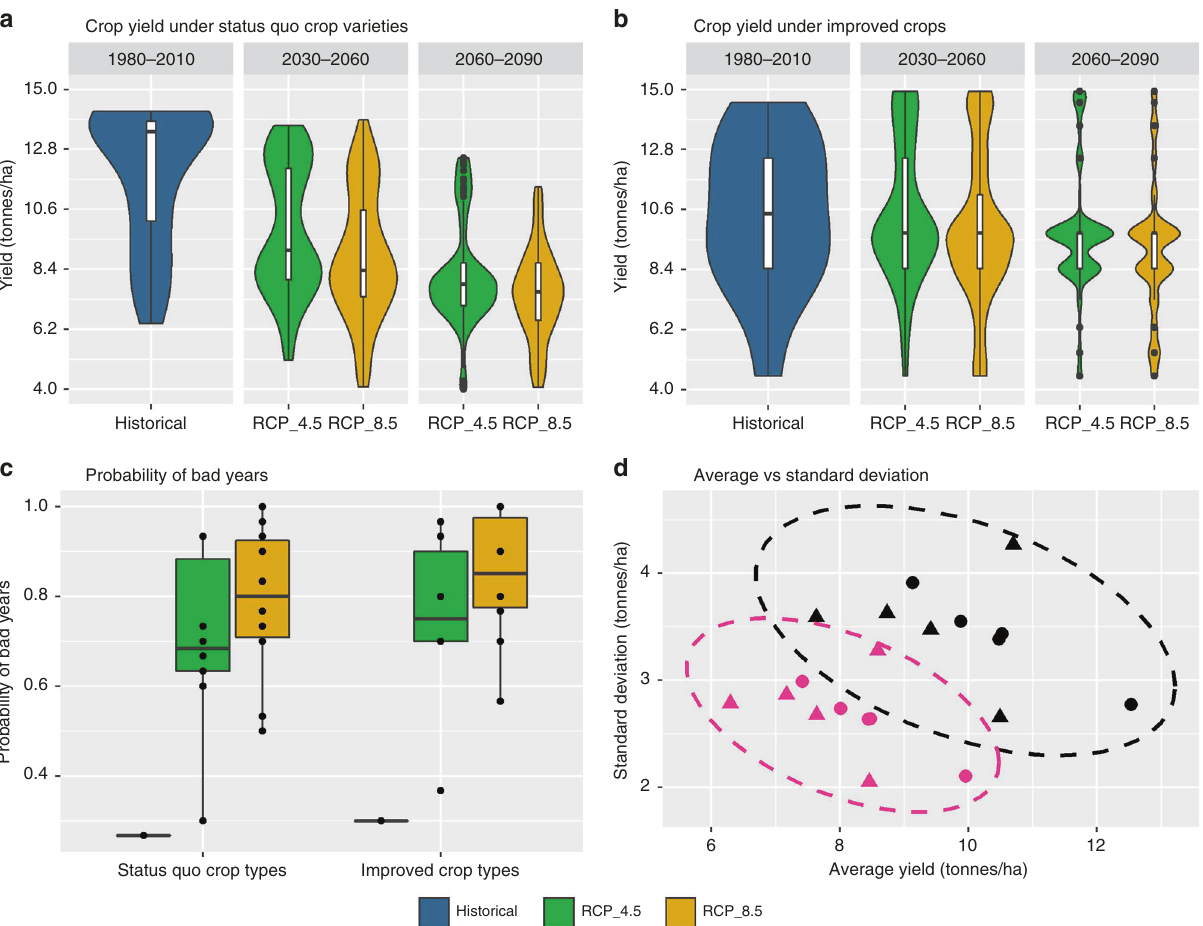
Fig. 3 Effects of improved crop varieties on agricultural productivity of irrigated potatoes (see Supplementary Fig. 5 – 13 for other crops). Panel a shows status quo productivity of potatoes over the historical period (1980 – 2010) and the two future periods: 2030 – 2060 and 2060 – 2090. Panel b demonstrates how improved potato varieties affect yield. The plots in panels a and b are called violin plots, which are essentially inverted actual probability distribution plots. Inside the violin plots, there are boxplots with the interquartile range of 50% (lower and upper quartile limits are 25% and 75%, respectively). The middle line in the boxplot represents median, whiskers can span to 1.5 times of upper and lower interquartile range, and dots show outliers. Panel c shows how probability of bad years changes with new crop varieties; a bad year in this study is de fi ned as years with productivity less than 60% of the fully irrigated yield. Boxplots in panel c have the same characteristics as boxplots inside the violin plots. Panel d shows the relationship between average yield and standard deviation for both the status quo crop (pink) and improved crop varieties (back). Oval curves in panel 4 show the bivariate Gaussian distribution for the con fi dence level of 0.95. Also, in panel c , n = 10 30-year average values of simulated yield calculated for fi ve GCMs over two future periods. Source data are provided as a Source Data fi